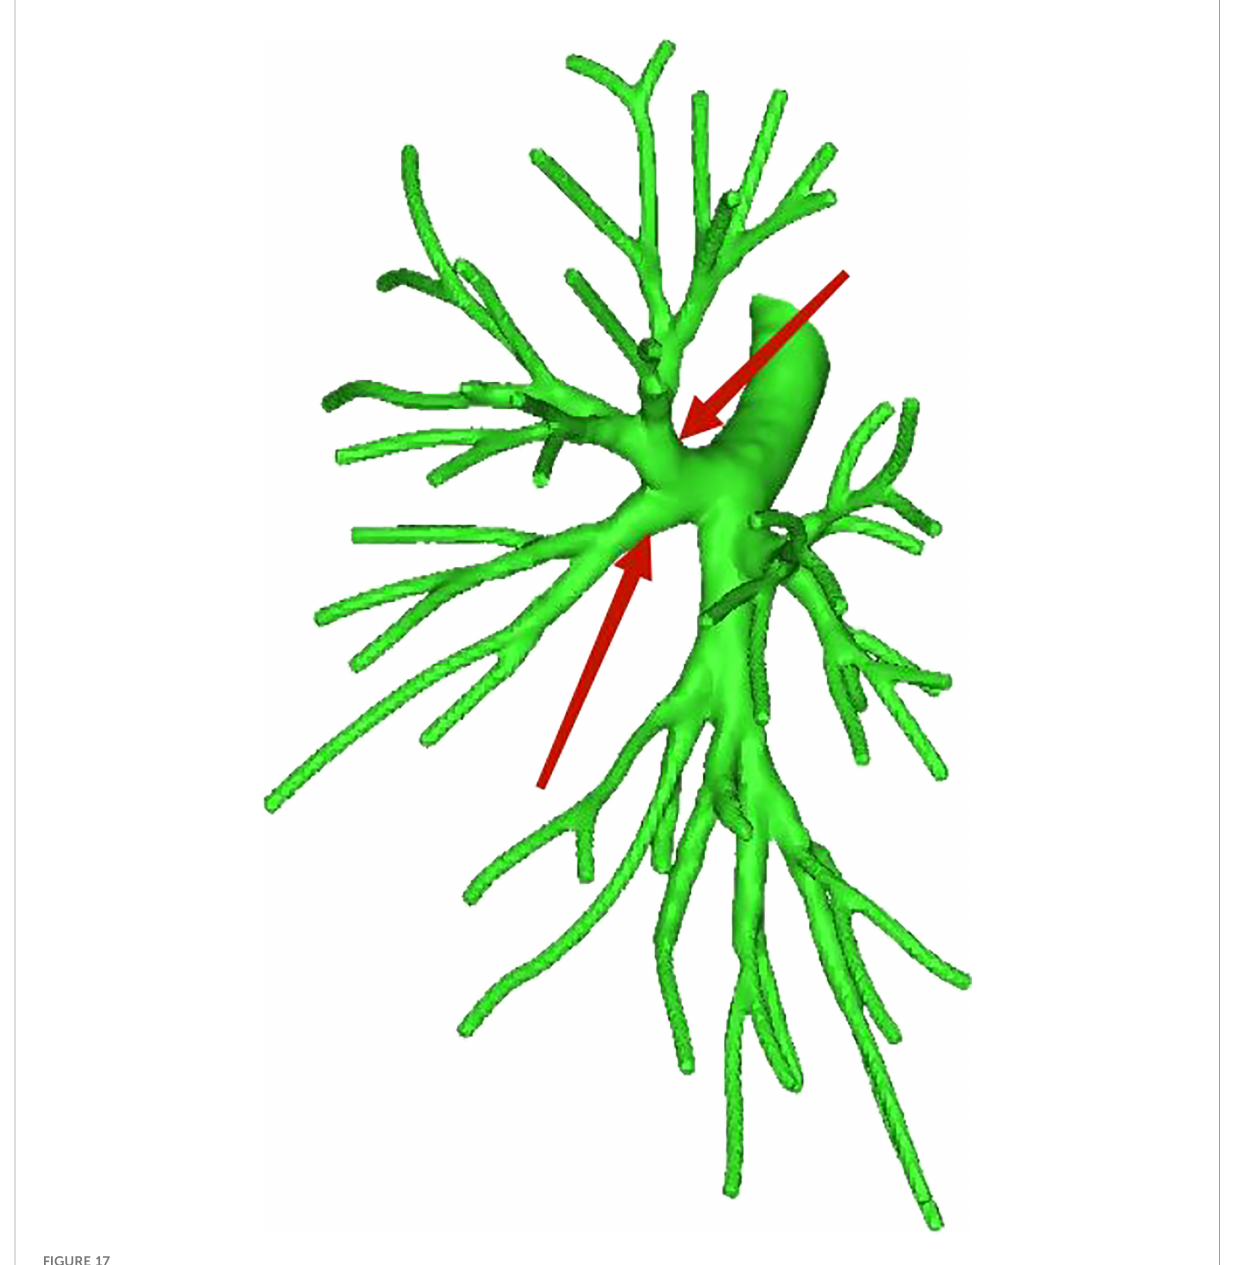
FIGURE 17 Bifurcation type; the branch mode was B1 + 2 + 3 and B4 +